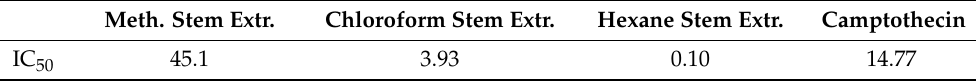
Figure 5. Cell viability of HEK293 cancer cell lines treated with different concentrations of D. villosa stem extract. Table 7. IC 50 values of methanol, chloroform and hexane extract of D. villosa stem against HEK293 cell. Meth. Stem Extr.